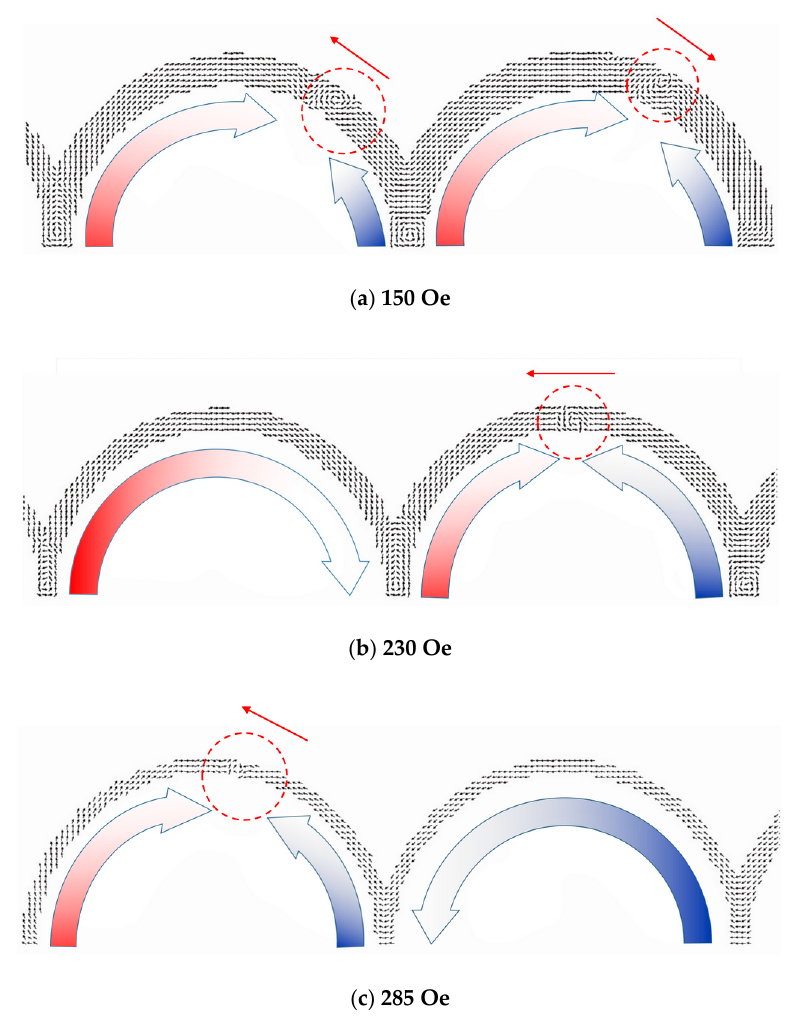
Figure 4. Simulation spin configuration around the switching of rings: ( a ) ring 5 and 6, ( b ) ring 3 and 4, and ( c ) ring 1 and 2. The small arrows indicate the propagation direction of domain wall (inside the dash circle), and the orientation of magnetization is illustrated by the arrow under the rings.